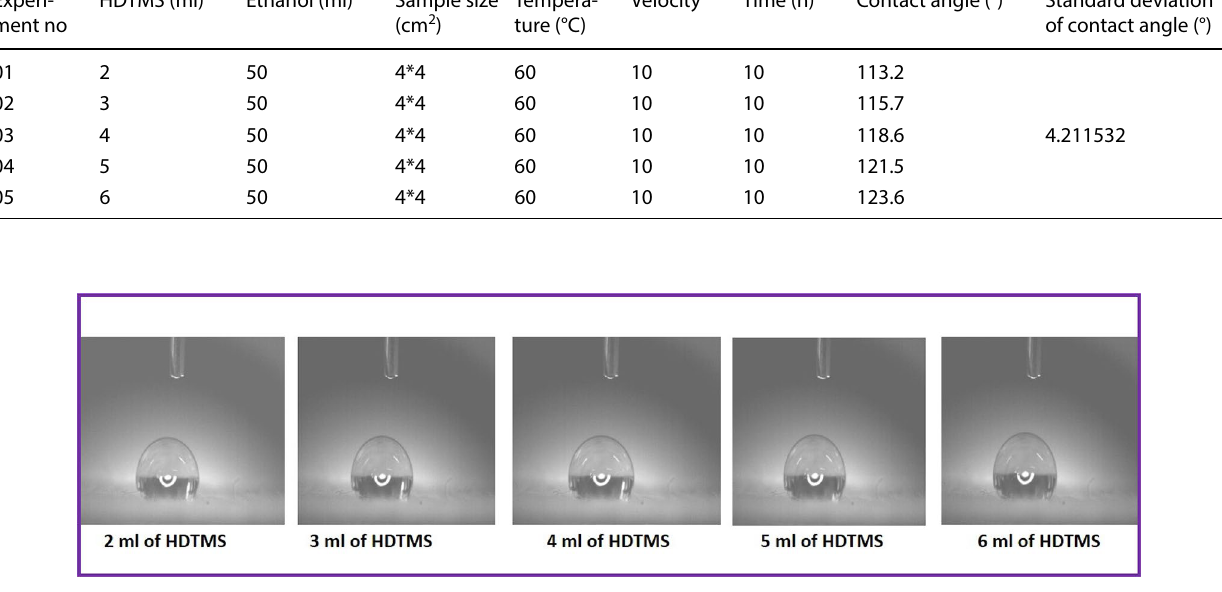
Fig. 6 Different contact angle for different amount of HDTMS using same parameters